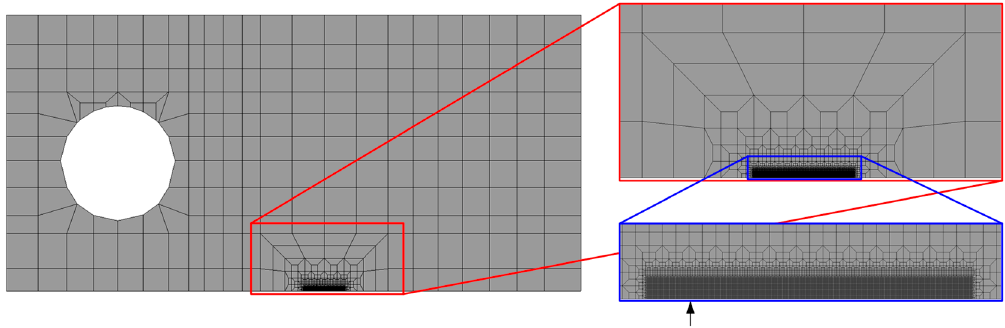
Figure 1. Finite element mesh of the specimen used in the numerical simulation.